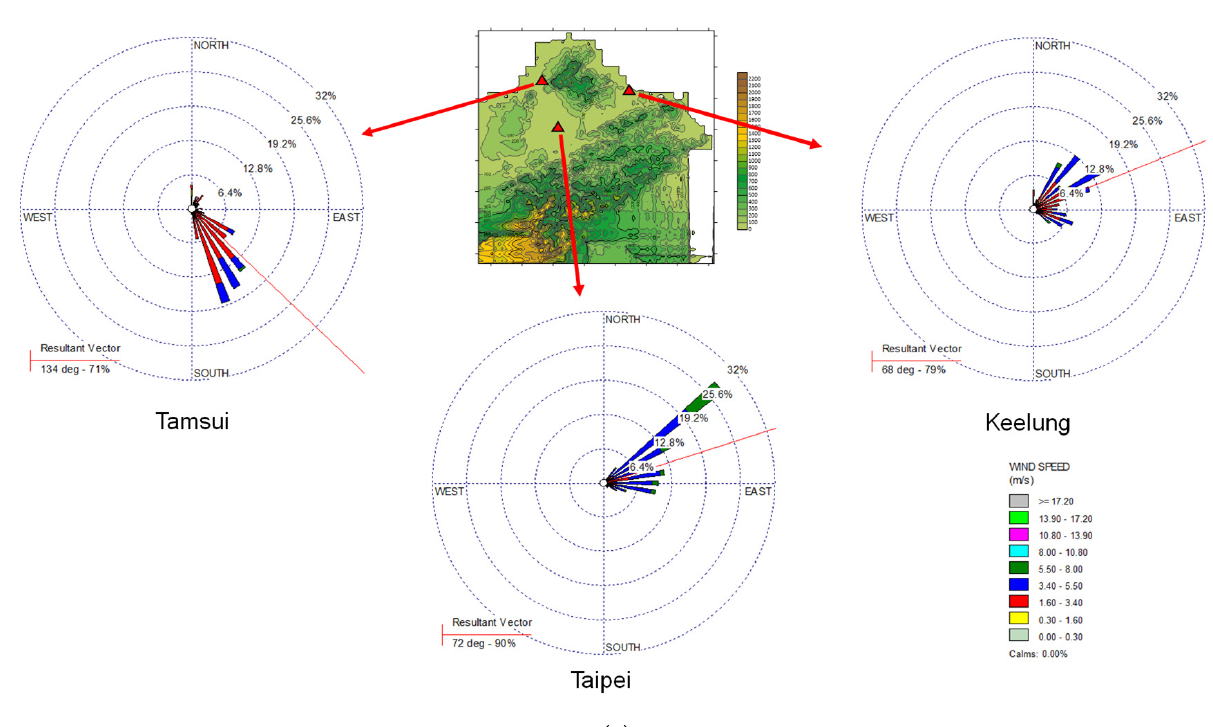
Figure 5. Wind roses for G2-A, G4-A, and G4-B in the upwind areas, Tamsui and Keelung stations, and the downwind area, Taipei station, of the Taipei Basin when rainfall amount was lower than 0.1 mm between 11:00 and 19:00 LST in the winter from 2016 to 2019: ( a ) G2-A: longitude of high-pressure centre > 125 ° E; T m > 20 °C; UHI > 0 °C; sea breeze; ( b ) G4-A: longitude of high-pressure centre > 125 ° E ; T m > 20 °C; UHI < 0 °C; sea breeze; ( c ) G4-B: longitude of high-pressure centre > 125 ° E ; T m > 20 °C; UHI < 0 °C; non-sea breeze. Red triangle symbols indicate the Tamsui, Taipei, and Keelung stations.